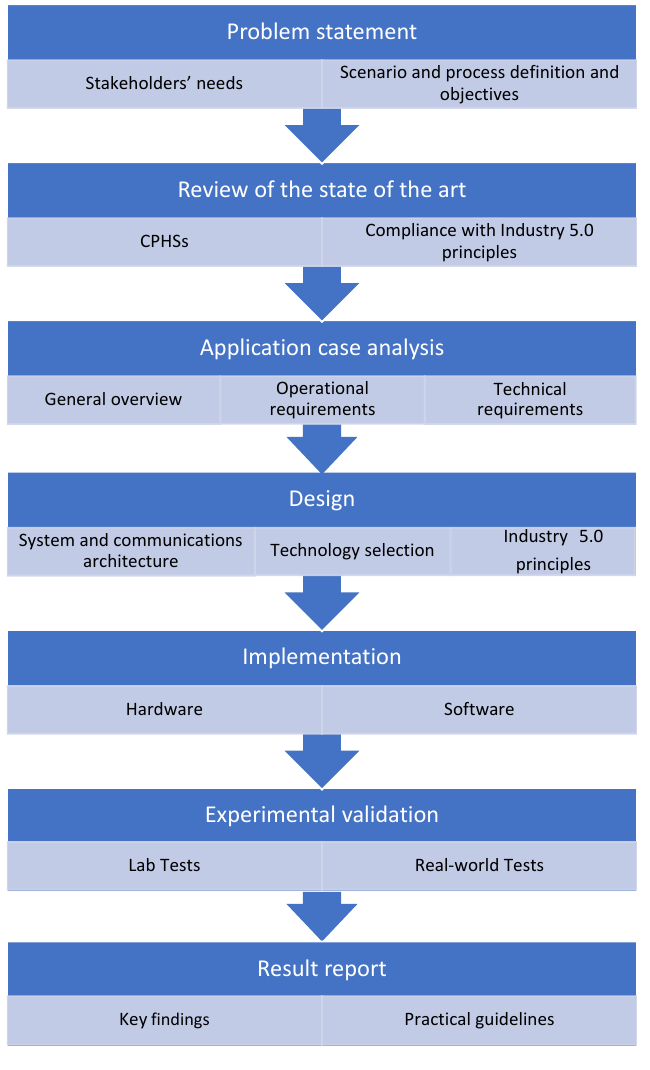
Figure 12. Proposed Industry 5.0 CPHS development